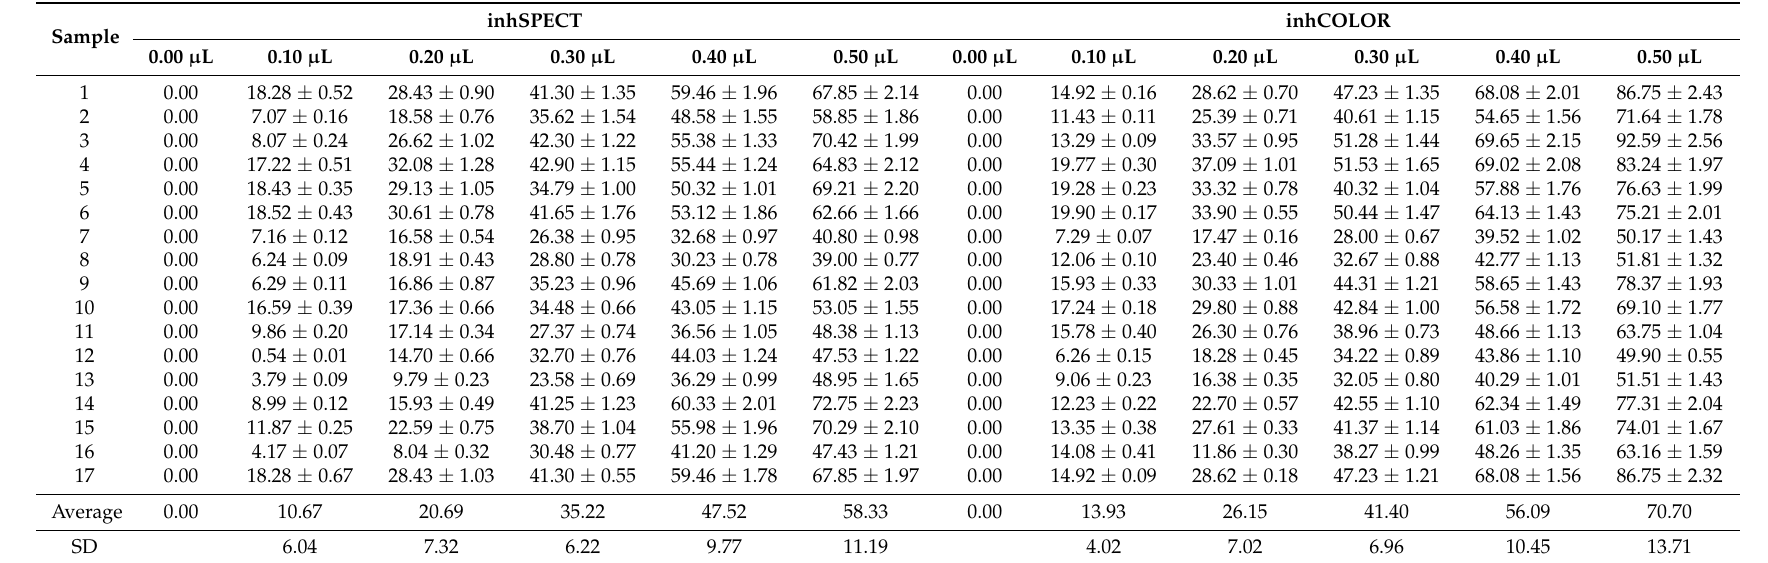
Table 1. Comparison of the DPPH assay Radical Scavenging Capacity (RSC) obtained from the colorimeter (inhCOLOR) and the Hitachi U-1900 spectrophotometer (inhSPECT). All measurements are the mean ± SD from each